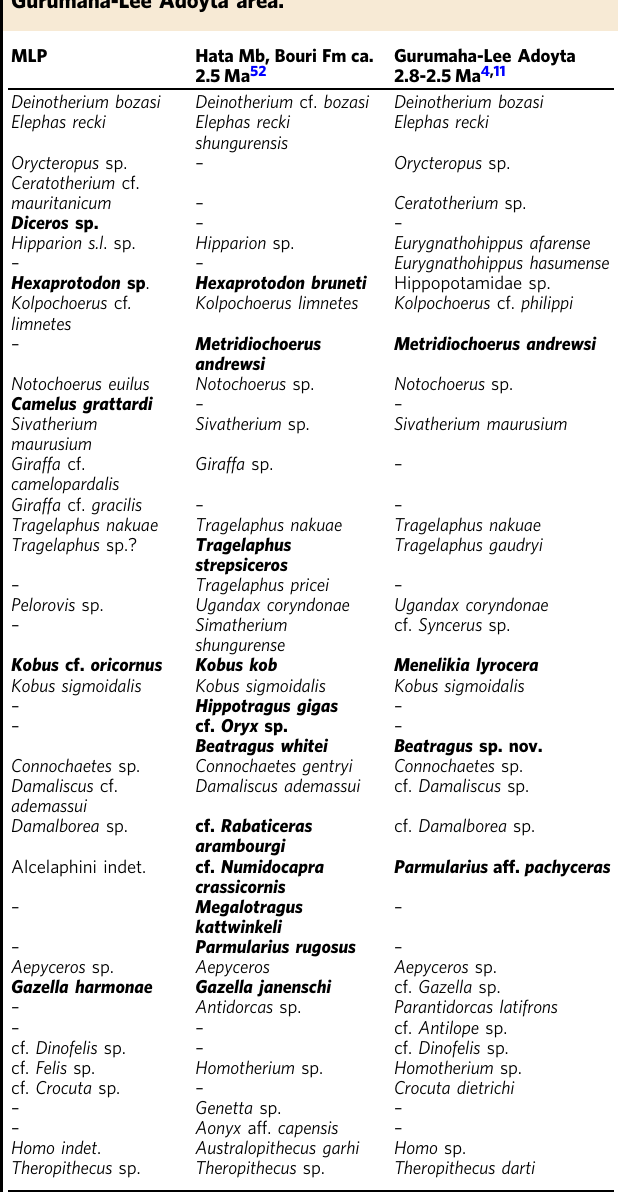
Table 2 Mille-Logya composite faunal list compared with those of the Hata Member of the Bouri Formation, and